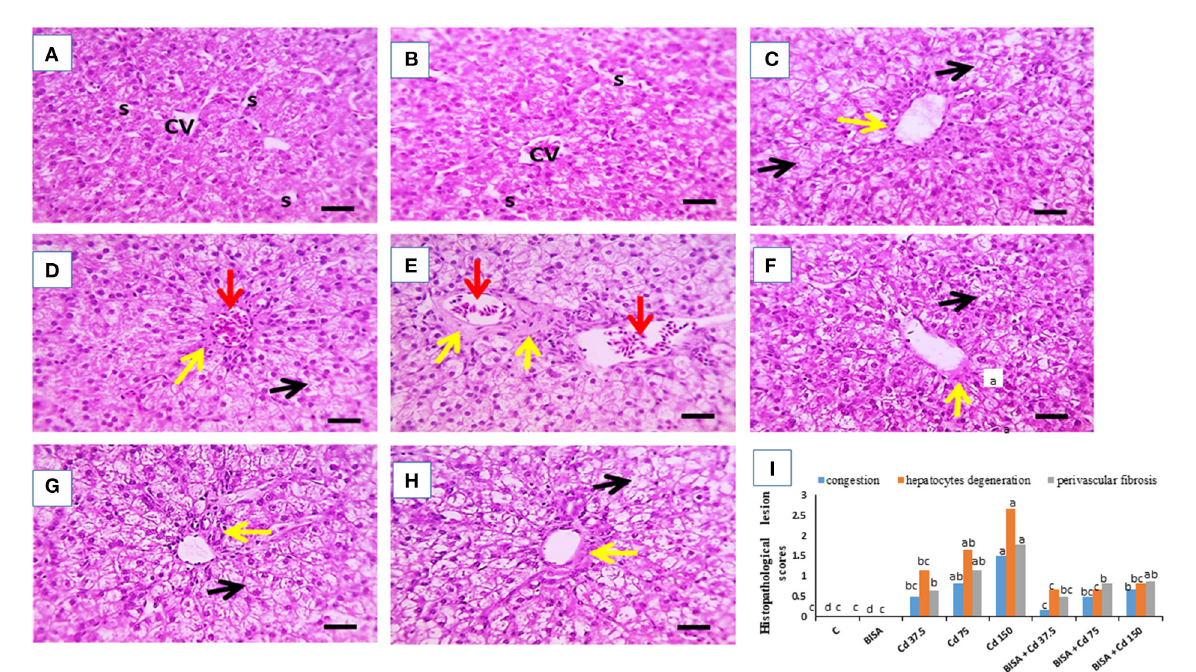
FIGURE2 Effect of oral α -bisabolol (BISA; 50 mg/kg/day) on histopathological alterations caused by CdCl 2 at different doses in ducks’ hepatic tissue. (A) is for the control group (C), and (B) is for the BISA alone group; both groups show normal hepatocytes (H), central vein (CV), and opened sinusoids (S). (C–E) represent groups receiving CdCl 2 at 37.5, 75, and 150 mg/kg diet, respectively, and showing hydropic degeneration in hepatocytes (black arrows), occluded sinusoids, congested central veins (red arrows), perivascular fibrosis (yellow arrows). The higher the dose of CdCl 2 , the more severe the lesions. (F–H) are for groups receiving BISA + CdCl 2 at 37.5, 75, and 150 mg/kg diet, respectively, exhibiting less severe lesions than those of the corresponding Cd alone groups. (I) shows the semiquantitative scoring of hepatic lesions. Lesions in 3 fields chosen randomly from each slide for each duck were determined. A blinded process was utilized for lesion scoring [Score scale: 0 = normal with 0% lesions; 1 = ≤ 25%; 2 = 26–50%; 3 = 51–75%; 4 = 76–100%]. The identification of hepatic lesions in ducks depended on the ratio of hepatocyte degeneration. congestion and fibrosis. Bars carrying different letters are significantly different from one another ( p < 0.05). Scale bar = 50 µ m. The sections were stained with H&E,